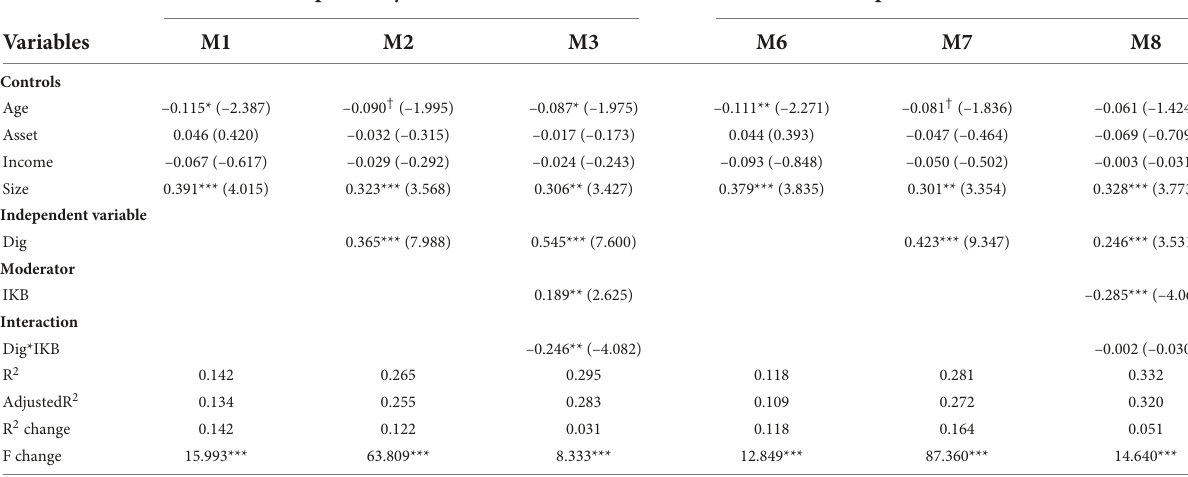
TABLE 4 Results of hierarchical regression analysis a .